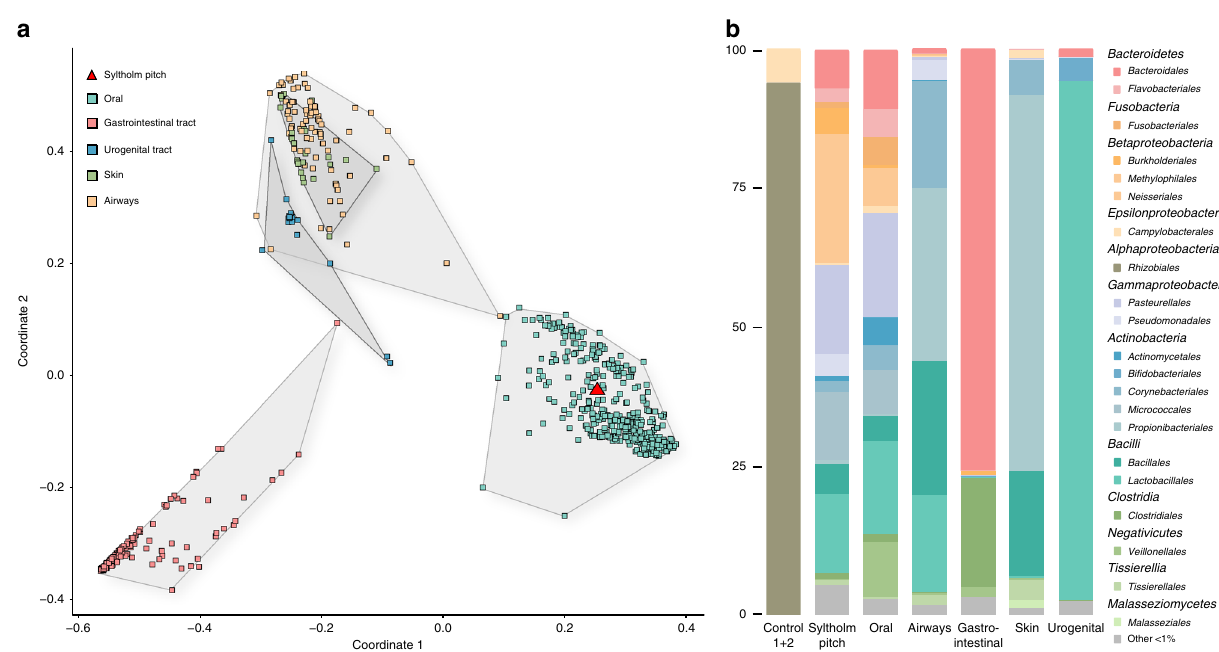
Fig. 3 Metagenomic pro fi le of the Syltholm birch pitch. a PCoA with Bray-Curtis at genera level with 689 microbiomes from HMP 14 and the Syltholm sample (see Methods). b Order-level microbial composition of the Syltholm sample compared to a control sample (soil) and metagenome pro fi les of healthy human subjects at fi ve major body sites from the HMP 14 , visualised using MEGAN6 15